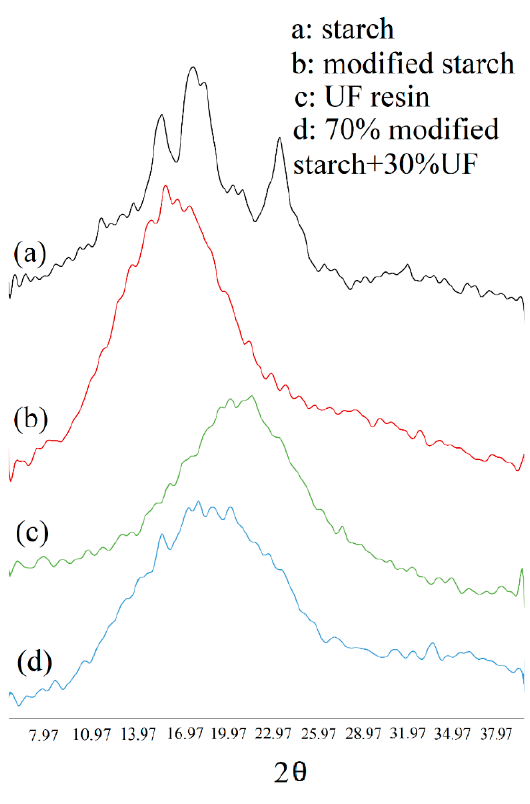
Figure 7. The XRD pattern for the index adhesives.